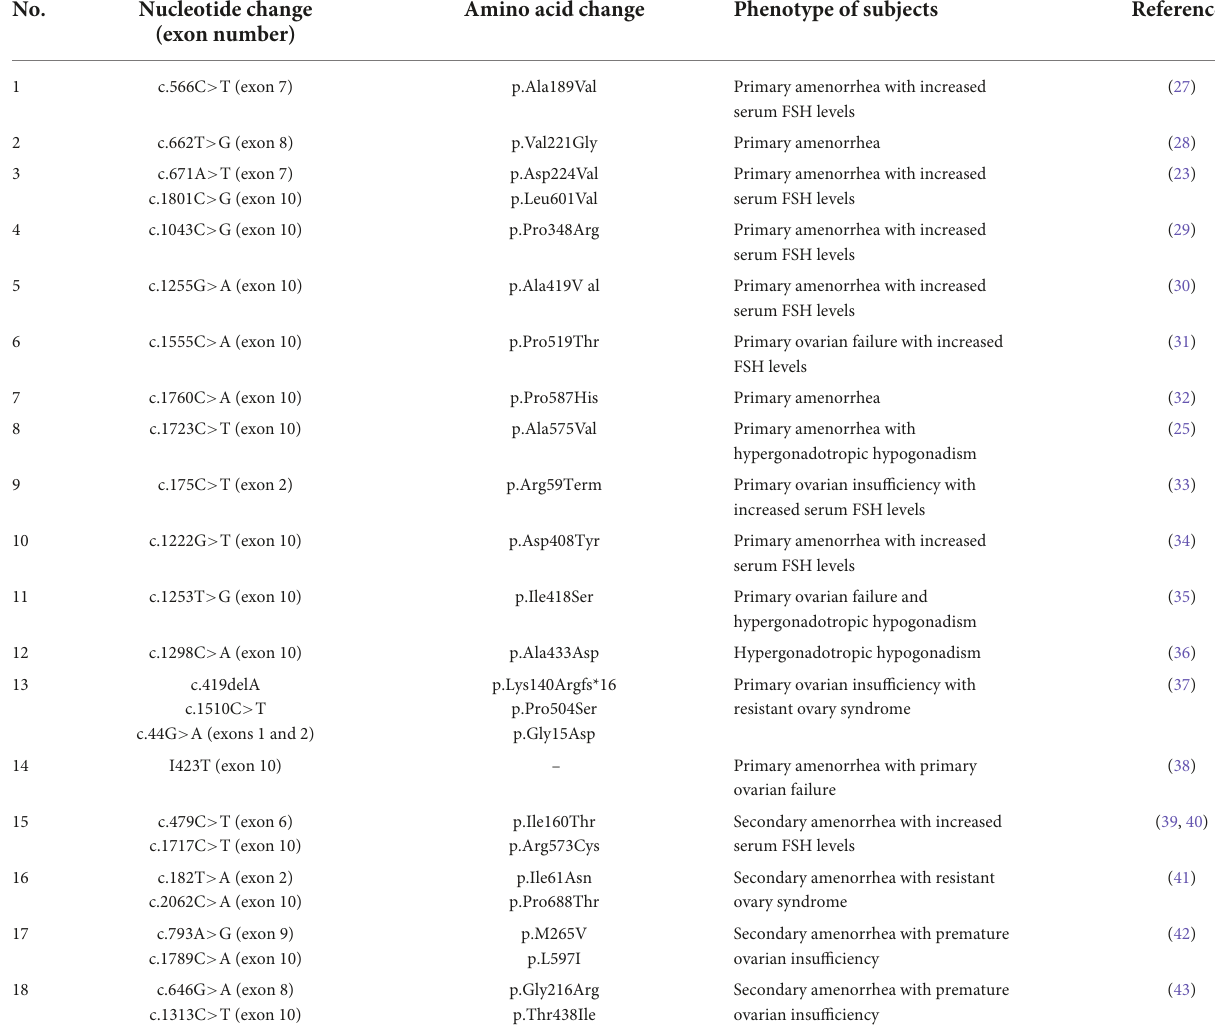
TABLE 1 Inactivating mutations of follicle-stimulating hormone receptor (FSHR) previously reported in women with ovarian dysgenesis, primary amenorrhea, and secondary amenorrhea.